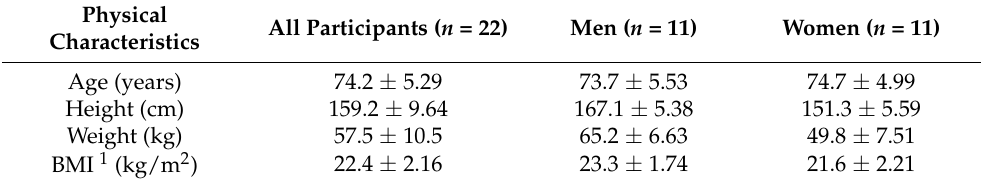
Table 1. Characteristics of study participants.